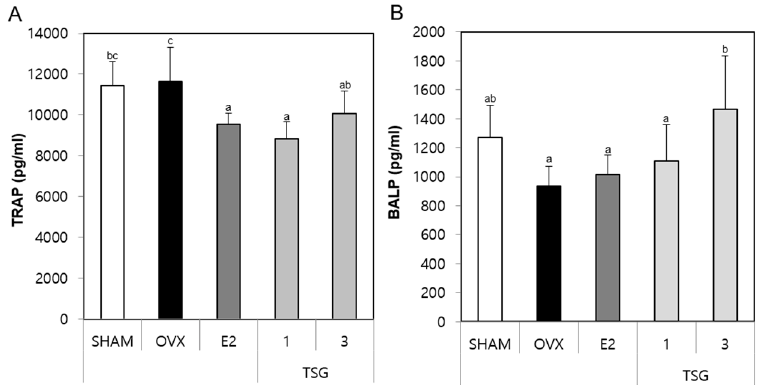
Figure 4. Effect of TSG on ( A ) tartrate-resistant acid phosphatase (TRAP) and ( B ) bone specific alkaline phosphatase (BALP) in the serum after six weeks of treatment. a, b, and c: The means not sharing a common letter are significantly different among groups at p < 0.05 by one-way ANOVA with Duncan’s multiple-range test.